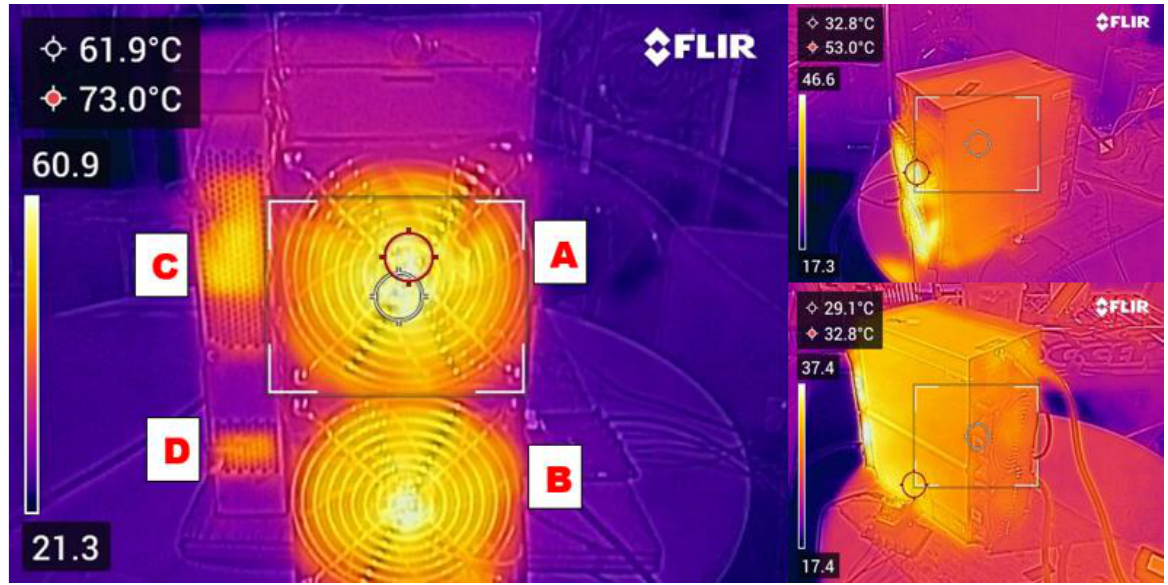
Figure 6. Antminer S17e heat localization thermal images measured in degrees Celsius. Label A and B denote the Antminer’s top and bottom main fans measured by probes 1 and 2, respectively. Labels C and D denote the Antminer’s top and bottom power supply fans measur ed.